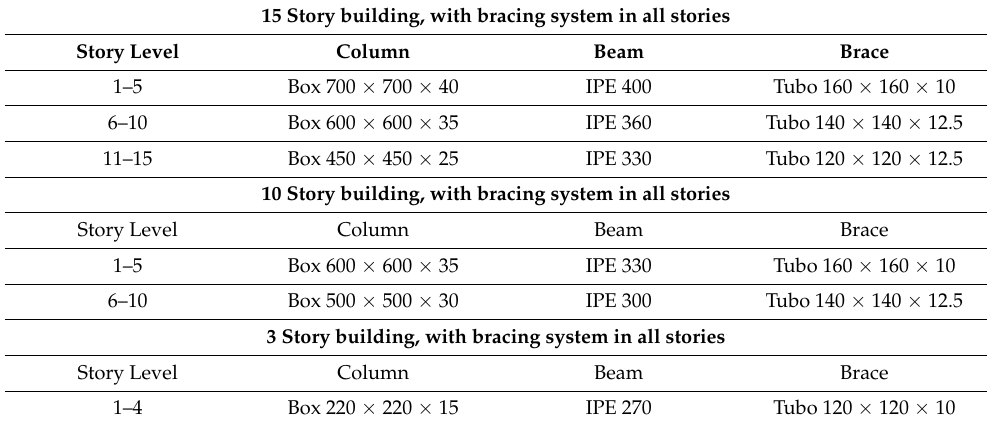
Table 2. Used sections in each selected buildings’ frame (for two types of connections in this